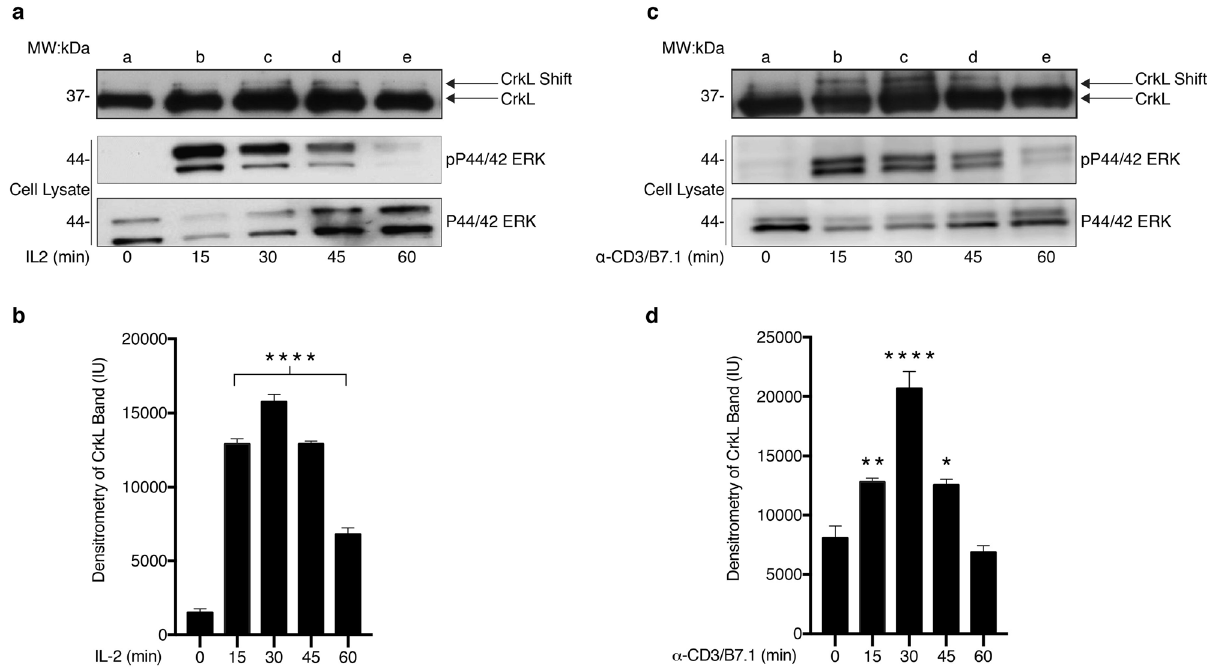
Figure 2. IL-2 and TCR stimulation induce post-translational modifications of CrkL detected by mobility shift. ( a ) Quiescent Kit225 cells were either left untreated (lane a ) or stimulated with 100 nM IL-2 for 0, 15, 30, 45, or 60 min (lanes b – e ). Cells were then subjected to immunoprecipitation for CrkL and protein was Western blotted with α-CrkL antibodies. Total cell lysate input was reserved and Western blotted for pP44/42 (α-pERK) (middle panel) and total P44/42 (α-ERK) (bottom panel). Full-length blots are displayed in Supplementary Fig. S2ab. ( b ) Densitometry analysis was performed on CrkL mobility shift from three independent experiments (n = 3) and the mean Intensity Units (IU) for each condition depicted in the bar graph. ( c ) Jurkat cells were either left untreated (lane a ) or stimulated with α-CD3 (5 µg) monoclonal antibodies and rhB7.1 (100 ng) for 0, 15, 30, 45, or 60 min (lanes b – e ). Cell lysate was subjected to immunoprecipitation for CrkL, protein and Western blotted with α-CrkL antibodies. Total cell lysate input was reserved and Western blotted for α-pERk (middle panel) and total ERK (bottom panel). Full-length blots are displayed in Supplementary Fig. S2cd. ( d ) Densitometry analysis was performed on CrkL mobility shift from three independent experiments (n = 3) and the mean Intensity Units (IU) for each condition depicted in the bar graph. (****) denotes P > 0.0001, (**) denotes P > 0.003, (*), denotes P >